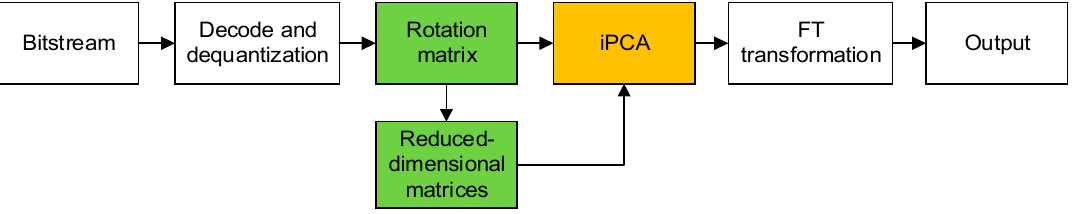
Figure 2. Flowchart of mono decoder. (iPCA, inverse Principle Component Analysis; FT, Frequency-to-Time).